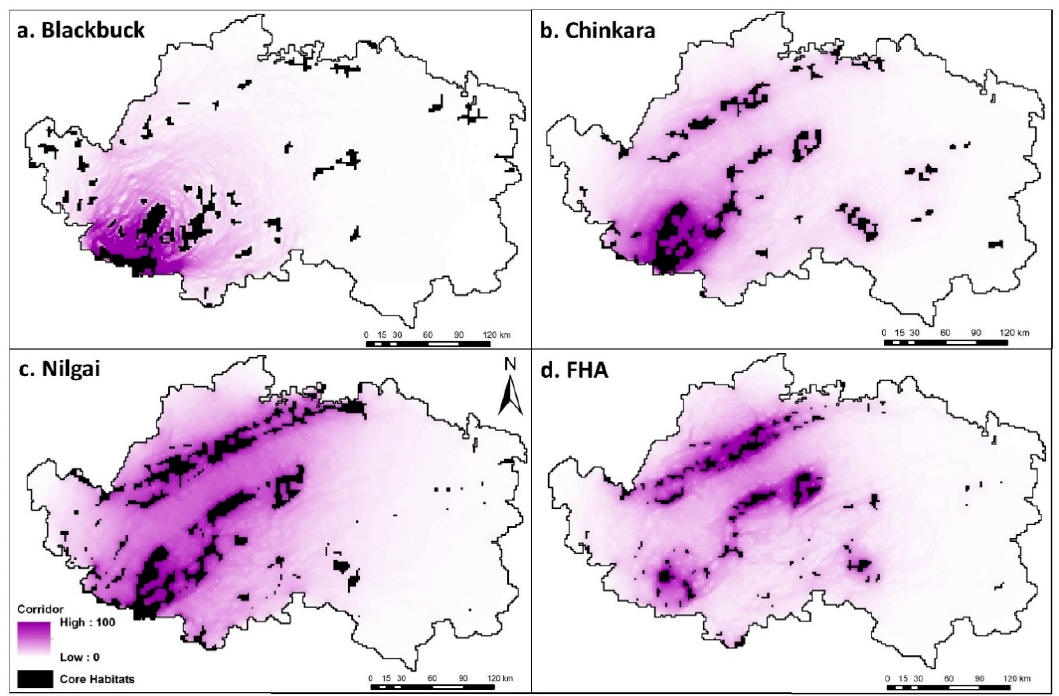
Figure 7. Core habitat patches and dispersal corridors of each focal species. FHA is four-horned antelope. ( a ) Blackbuck; ( b ) Chinkara; ( c ) Nilgai; ( d ) FHA.